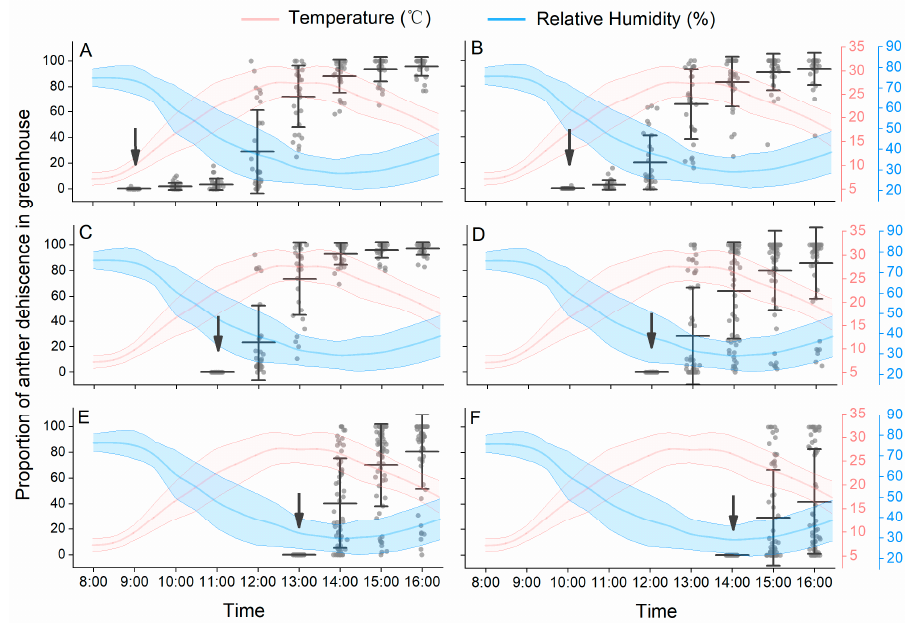
Figure 2. Peach anther dehiscence dynamics under solar greenhouse conditions. The panels ( A – F ) represent anther dehiscence dynamics of flowers opened at different time of day. The arrows indicate the time when flowers fully opened. Data are presented as the mean ± S.D.